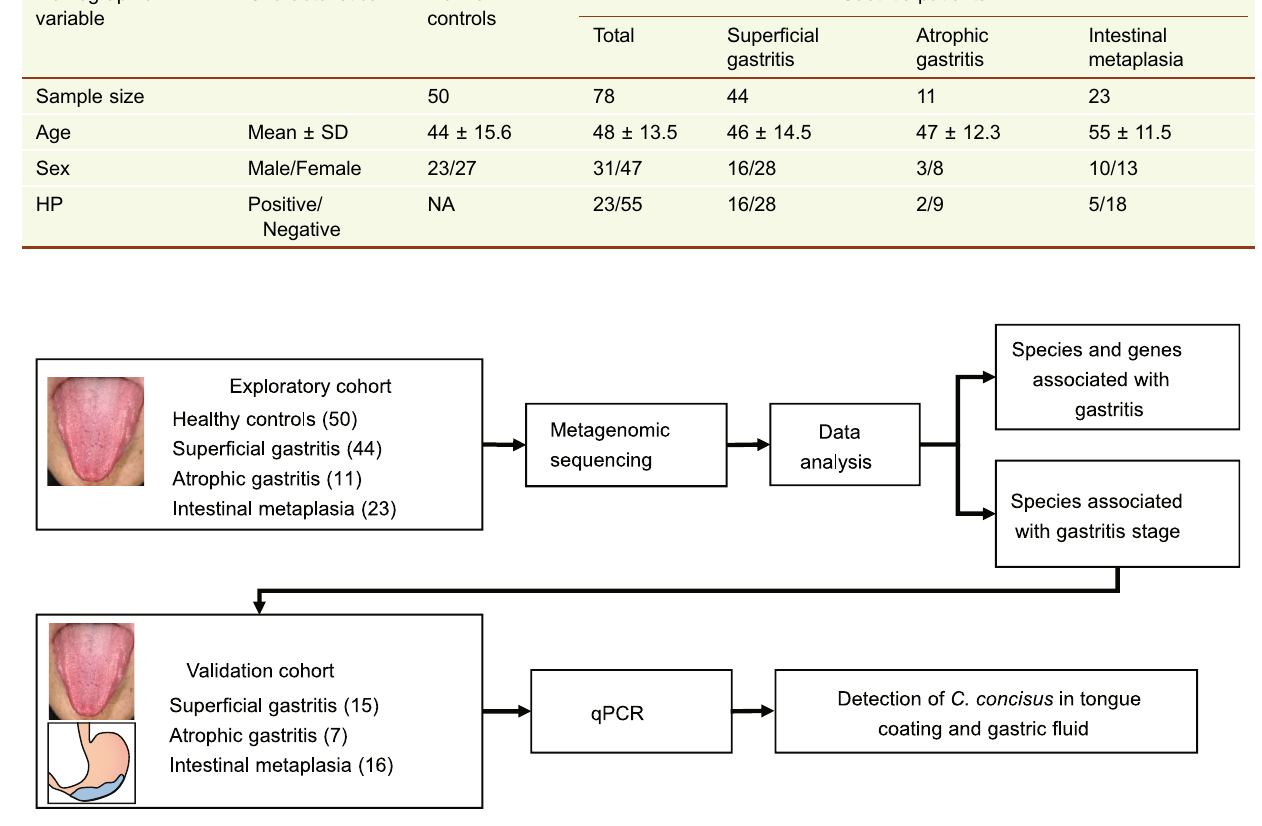
Figure 1. Graphic summary of the